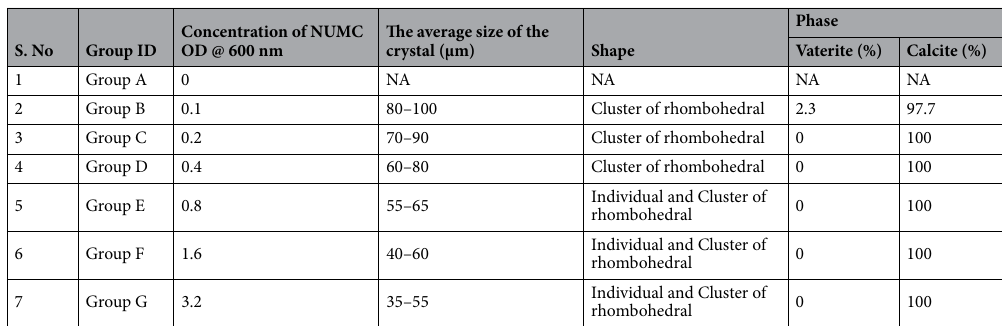
Table 3. The influence of native ureolytic microbial community concentration on the morphology and phase of CaCO 3 crystals. NUMC Native Ureolytic Microbial Community, NA not applicable.